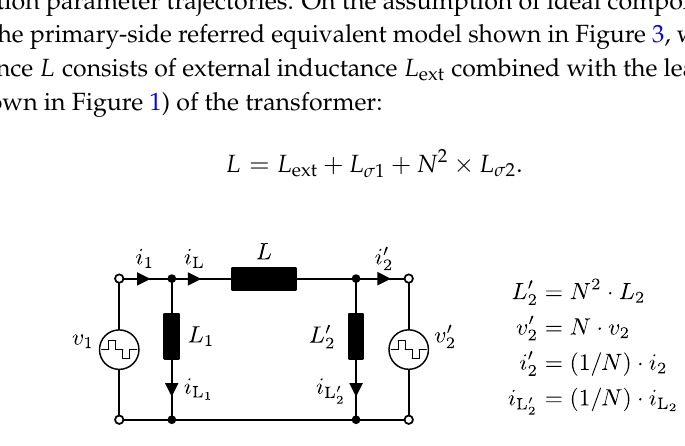
Figure 3. Simplified (lossless), primary-side referred equivalent model of the DAB dc-dc